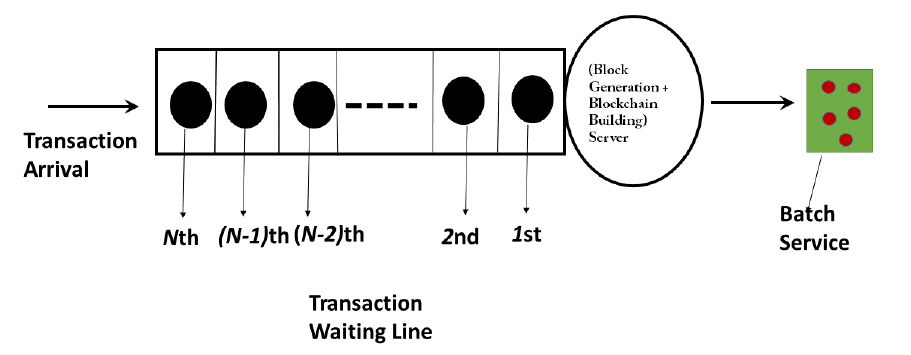
Figure 1. M / G ( a , b ) /1/ N blockchain queueing